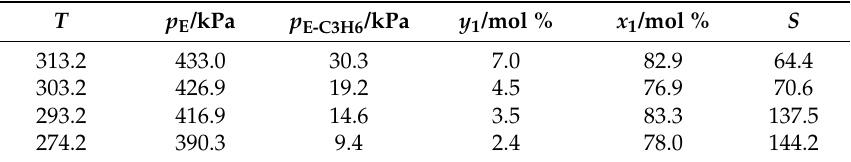
Table 4. Separation results for C 3 H 6 (1) + H 2 (2) gas mixtures ( z 1 = 0.35) using a ZIF-8/water-glycol slurry where the mass ratio between water and glycol in the solution was specified to 4:1 with 20 wt % ZIF-8 at nearly the same initial pressure of approximately 700 KPa, but with different temperatures. S is the apparent selectivity of C 3 H 6 over H 2 in the